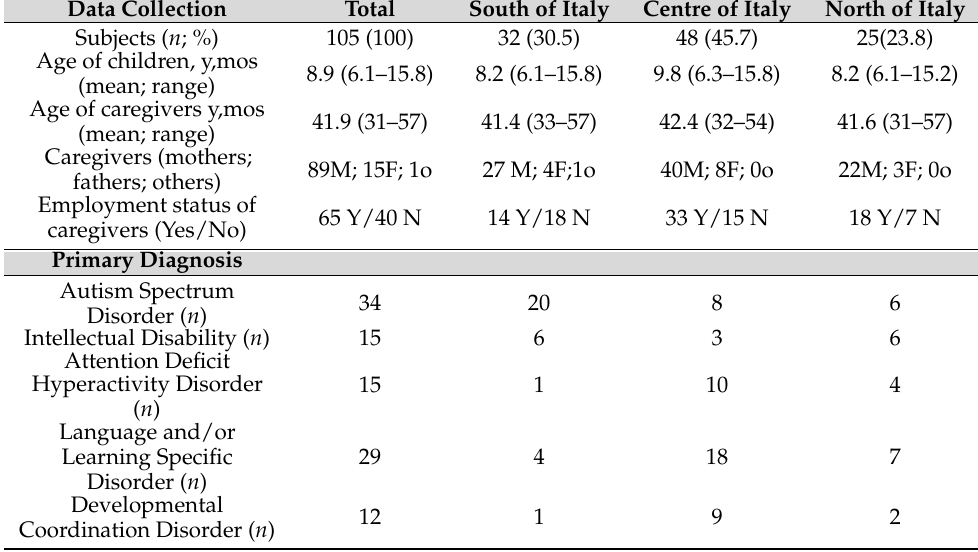
Table 1. Distribution and principal sociodemographic information of the sample.